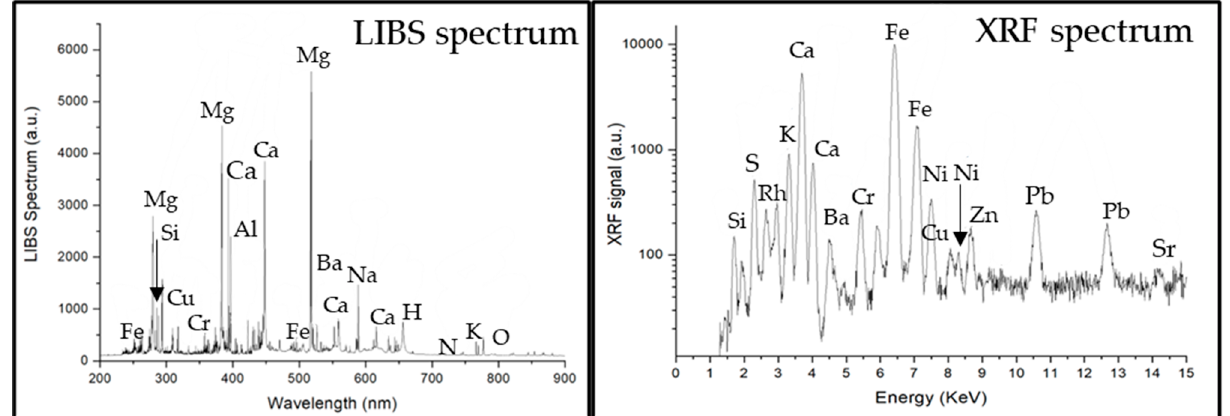
Figure 2. Representative analyses of the four investigated black stones by laser-induced breakdown spectroscopy (LIBS) and X-ray fluorescence (XRF). Spectra (both LIBS and XRF) are very similar for each of the four black stones of the Casa Leopardi’s child home.